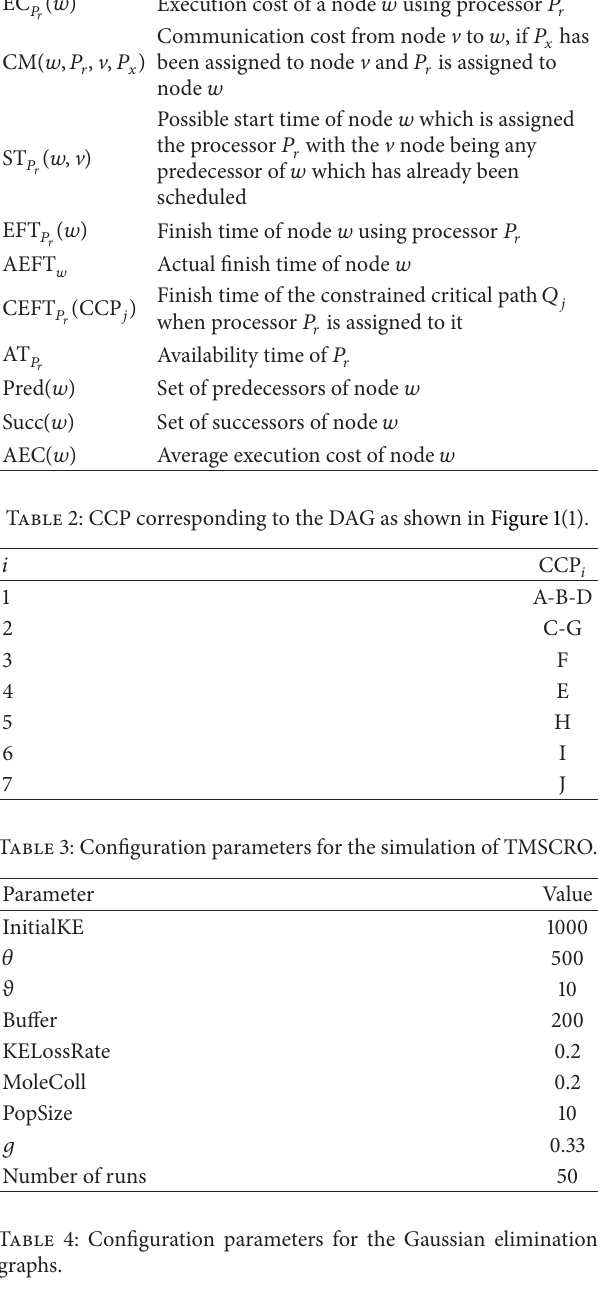
Table 1: Specific terms and their usage for the CEFT algorithm. (𝑤) EC 𝑃 𝑟